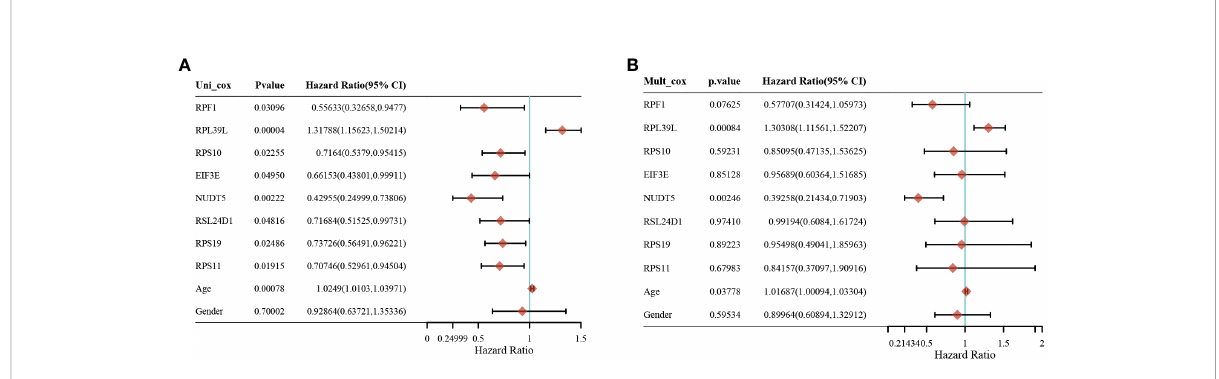
FIGURE 5 Screening of independent prognostic factors for glioma based on univariate and multivariate cox analyses. (A) Univariate cox analysis of prognostic genes. (B) Multivariate cox analysis of prognostic genes.